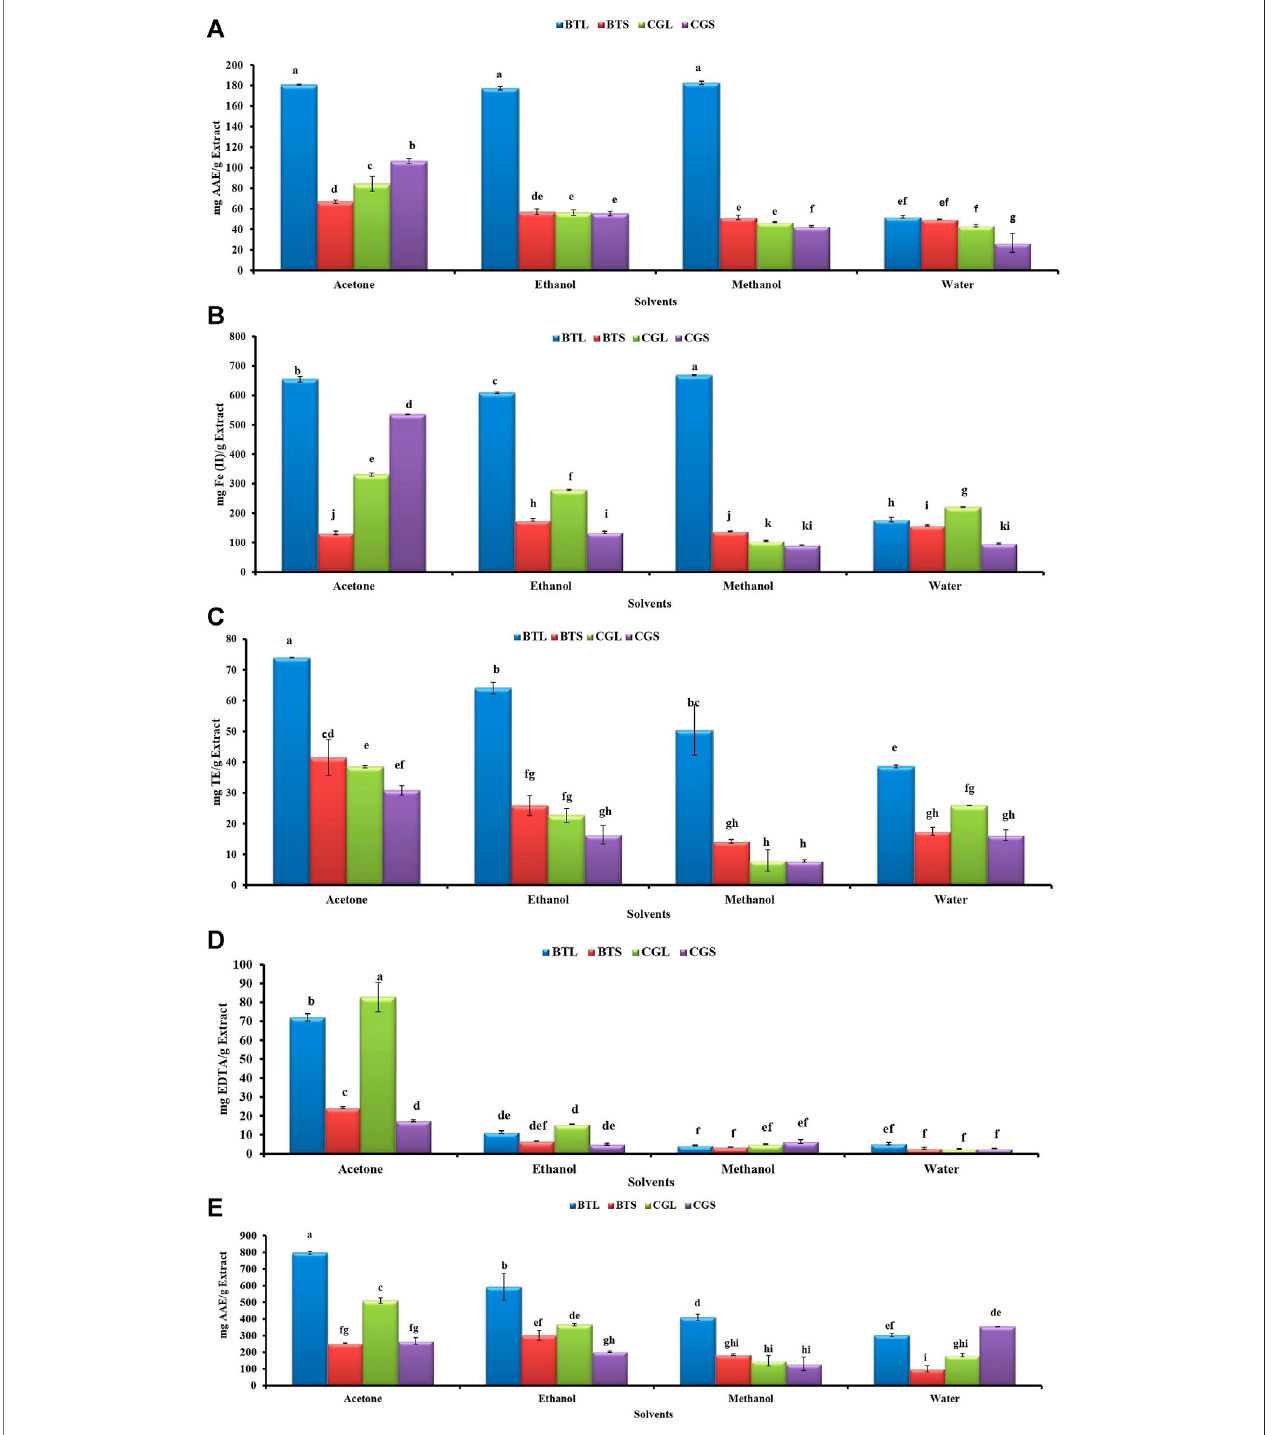
FIGURE1 | Antioxidant activitiesfrom the different extracts of B. terminalis and C. grandi fl orus (A) DPPH radical scavenging activity, (B) FRAP activity, (C) ABTS+ radical scavenging activity, (D) Metal chelating activity, (E) Phosphopmolybdenum reduction activity. Note — All fi gures indicate different extracts from leaves and stems of BTL — B. terminalis leaves, BTS — B. terminalis stem and CGL — C. grandi fl orus leaves and CGS — C. grandi fl orus stem. According to DMRT, Bars having different alphabets showed statistically signi fi cant differences ( p ≤ 0.05).